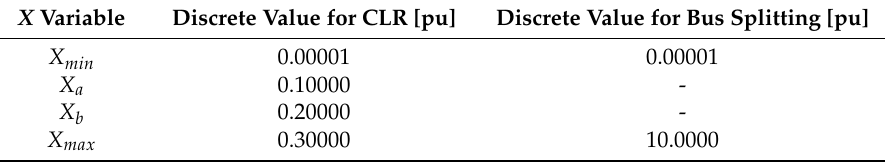
Table 1. Parameter setting example for discretization. CLR: current limiting